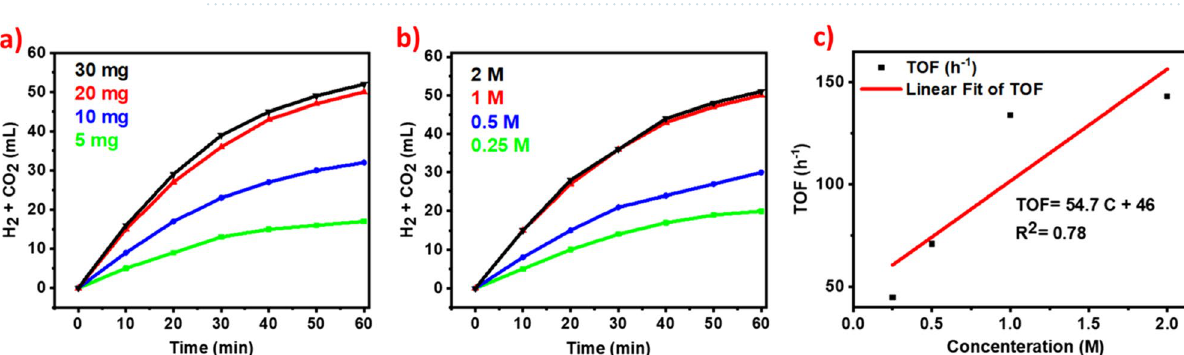
Figure 8. ( a ) Time-dependent gas evolution plots from FA in the light irradiation at ~ 30 °C for Ag 1 Pd 1 /SLCN versus Ag